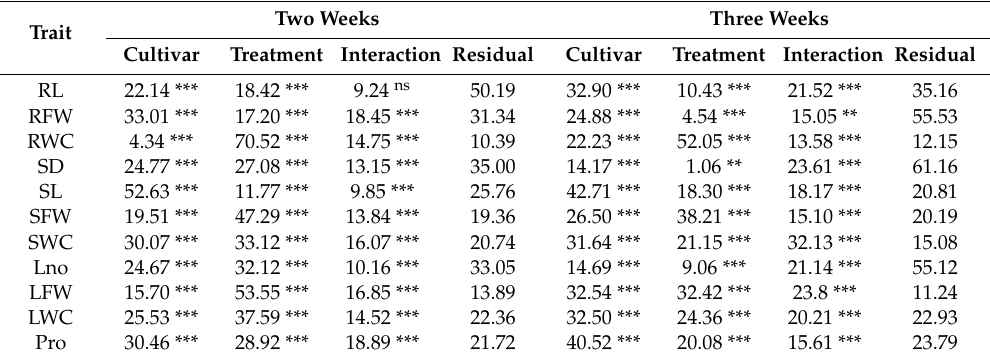
Table 2. Two-way analysis of variance (ANOVA) of cultivar, treatment and their interactions for the parameters considered. Numbers represent percentages of the sum of squares at the 5% confidence level. Abbreviations: RL, root length; RFW, root fresh weight; RWC, root water content; SD, stem diameter; SL, stem length; SFW, stem fresh weight; SWC, stem water content; Lno, leaf number; LFW, leaf fresh weight; LWC, leaf water content; Pro, proline content. Asterisks indicate the degree